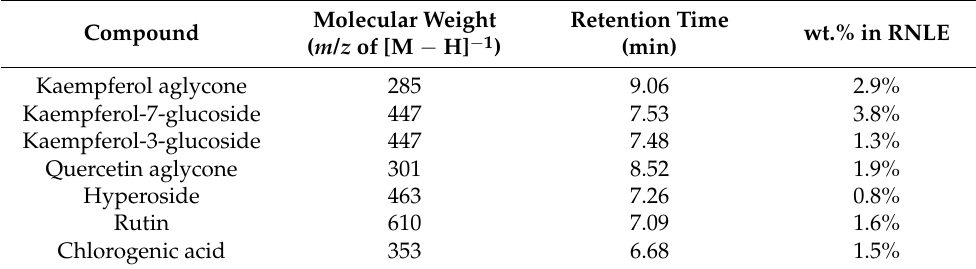
Table 1. Quantitative analysis of phenolic compounds occurring in